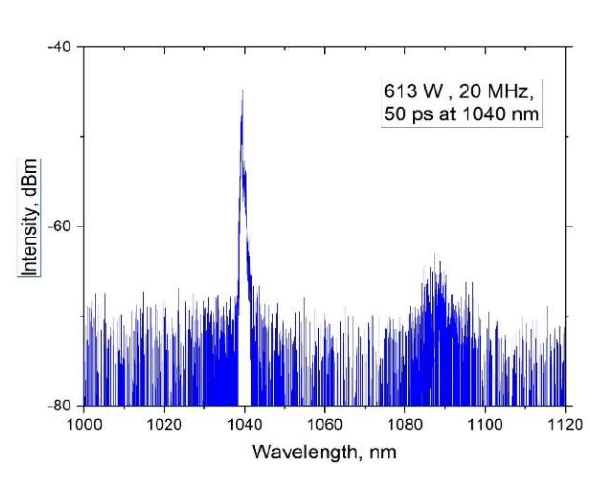
Fig.3. Output power of MOPA system vs total pump power.